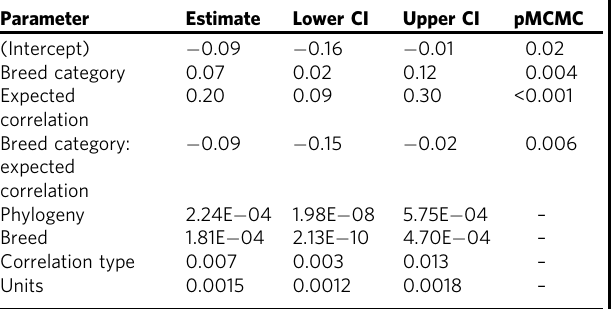
The model output from the Bayesian general linear mixed model on positive vs. negative correlations within and between prosocial and reactive behaviours in ancient and modern breeds. Estimates, 95% con fi dence intervals (CI) and pMCMC values for the intercept, breed category (ancient or modern), expected correlation (positive or negative), the interaction term between breed category and expected correlation are speci fi ed. Random factors are the phylogeny, breed (78 different breeds) and the correlation type (e.g. sociability vs. playfulness)